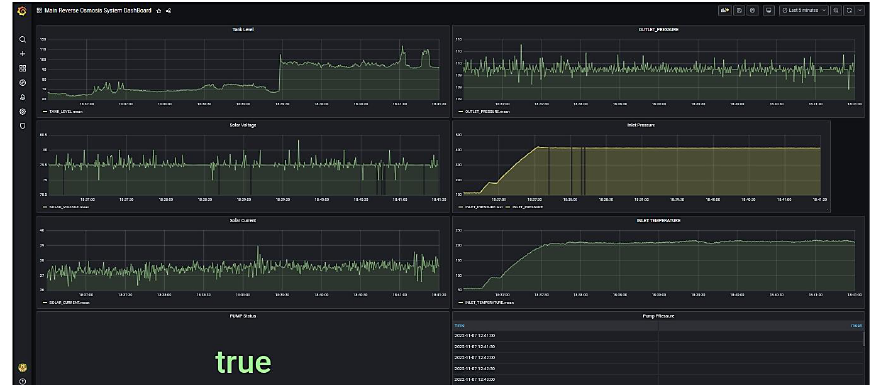
Figure 15. Grafana-based dashboard for historical data trending and data analytics.